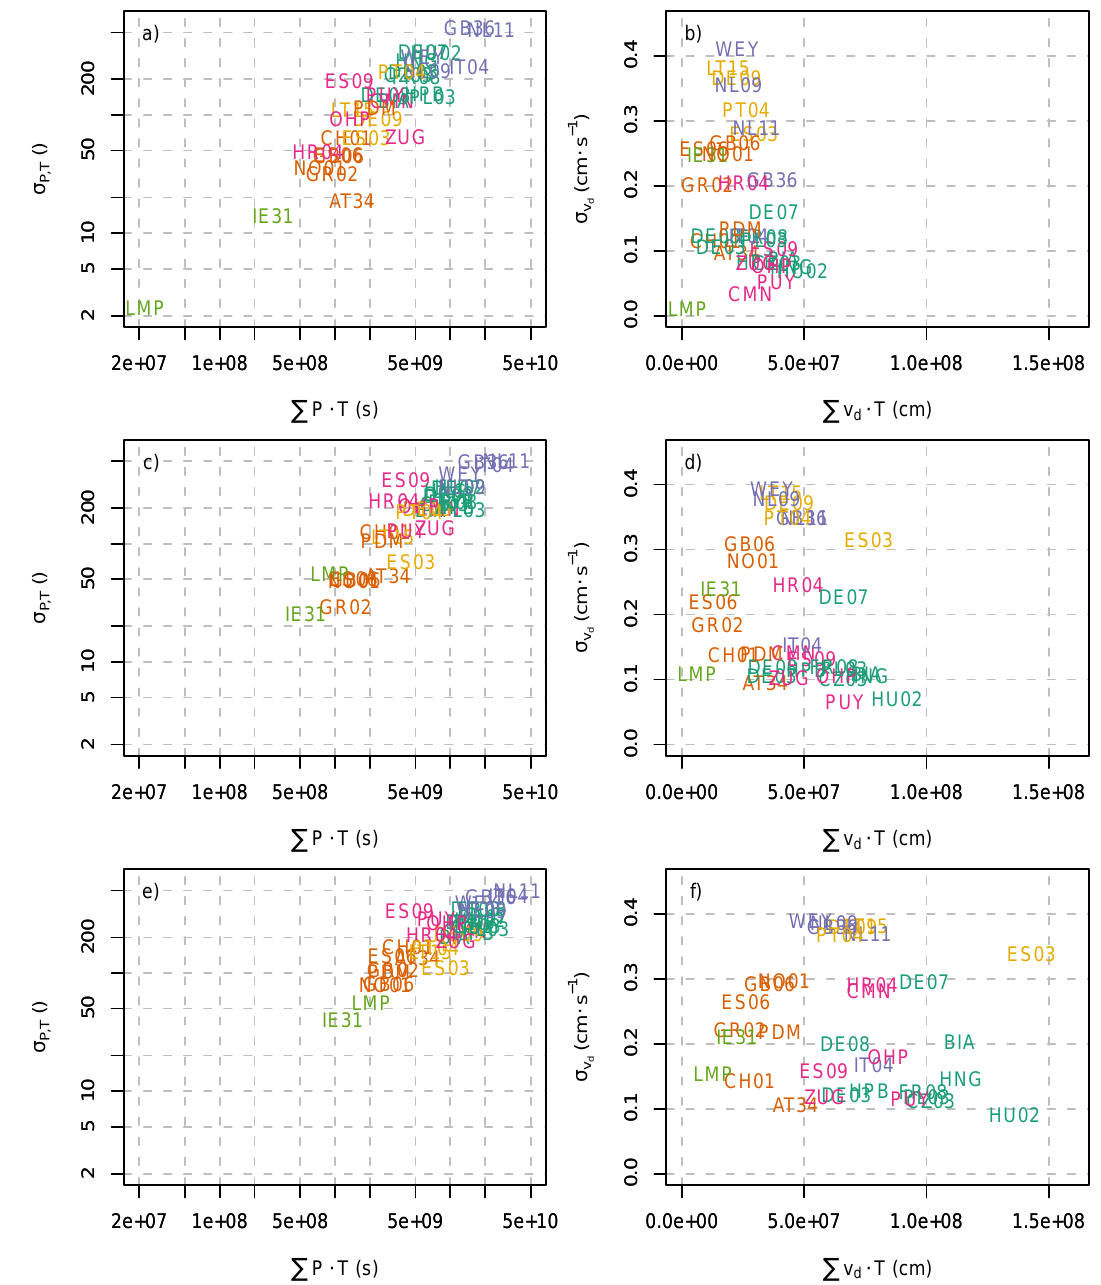
Fig. 2. Scatter plots of population variability σ P,T versus population sum P P T for (a) 12h, (c) 24h, (e) 48h catchment area and deposition variability σ v versus deposition sum P v d T for (b) 12h, (d) 24h) (f) 48h catchment area. The colours refer to the categories identified d ,T by the site categorisation, compare Fig.